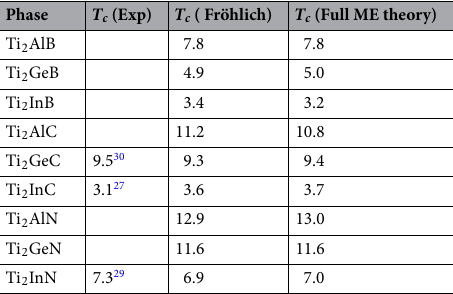
Figure 1. For Ti 2 AX (A: Al, Ge and In; X: B, C and N), the results for T c computed using µ ∗ Migdal–Eliashberg theory are presented as red (X = B), blue (X = C) and magenta (X = N) squares, and the corresponding experimental data are displayed as black circles, with linear best fit to the theoretical values in red, blue and magenta dashed lines. Red, blue and magenta dashed lines represent a simple Fröhlich model for estimating superconducting transition temperature T c . Full data in Tables 1 and 2.